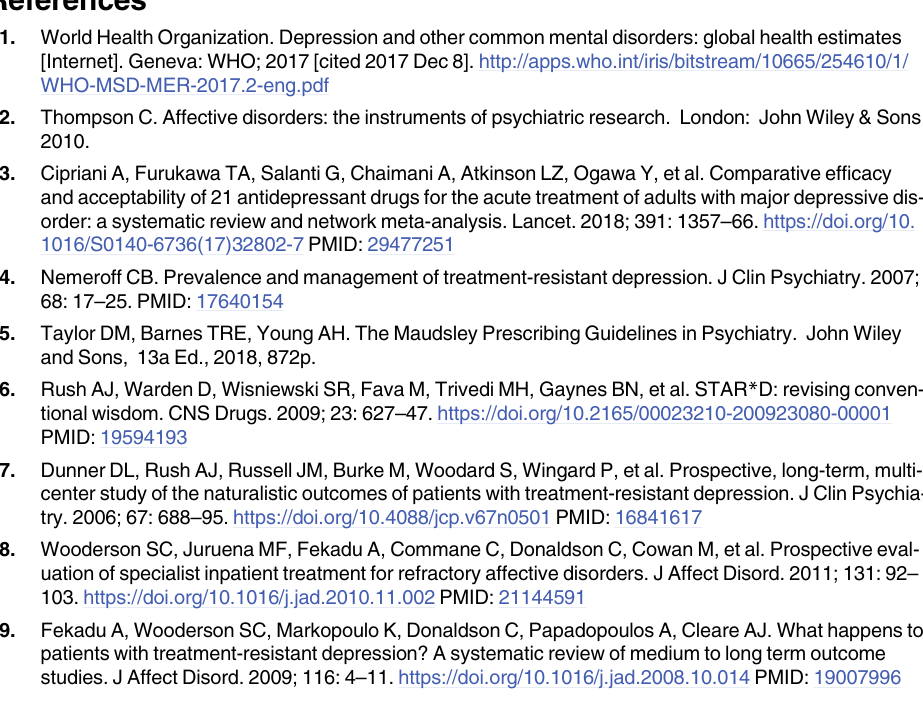
S1 Fig. Flowchart of CPG